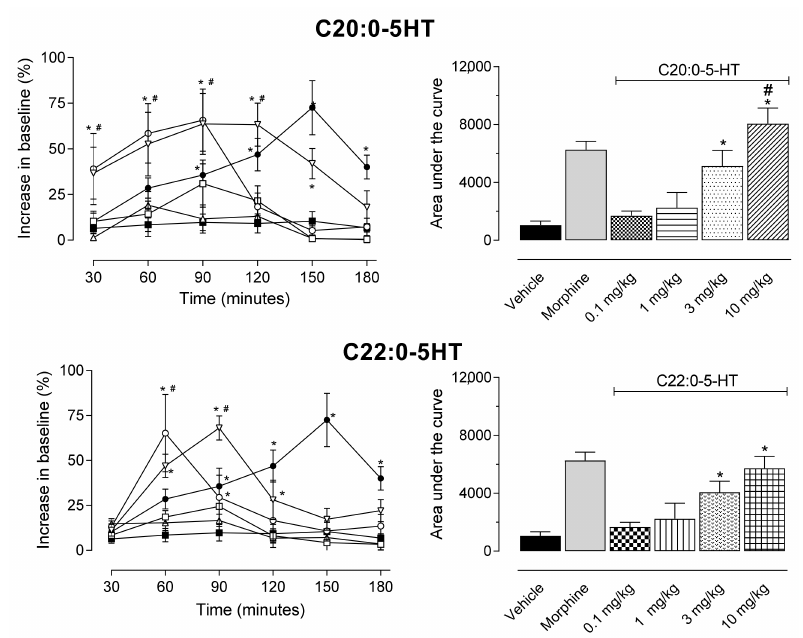
Figure 3. Antinociceptive effects of β N -arachinoyl-5-hydroxytryptamide (C 20:0 -5HT) and β N - behenoyl-5-hydroxytryptamide (C 22:0 -5HT) evaluated in the hot plate model. Animals were orally pretreated with different doses of C 20:0 -5HT or C 22:0 -5HT, morphine (5 mg/kg), or vehicle. Left graphs (line graphs) represent the time of response to the hot plate (shown as a percentage increase in relation to the baseline) evaluated between 30 and 180 min after oral administration. The right graphs represent the area under the curve calculated based on data obtained from line graphs. The results are presented as mean ± SD ( n = 8 per group) of the increase in baseline (left graphs) or area under the curve (right graphs) calculated by two-way ANOVA followed by Tukey’s post hoc test. Morphine and higher doses (3 and 10 mg/kg) of C 20:0 -5HT and C 22:0 -5HT showed a significant increase in AUC as compared with the vehicle-treated group. C 20:0 -5HT (at 30 mg/kg) demonstrated a significant effect as compared with the morphine-treated group. * p < 0.05 as compared with the vehicle-treated group and # p < 0.05 as compared with the morphine-treated